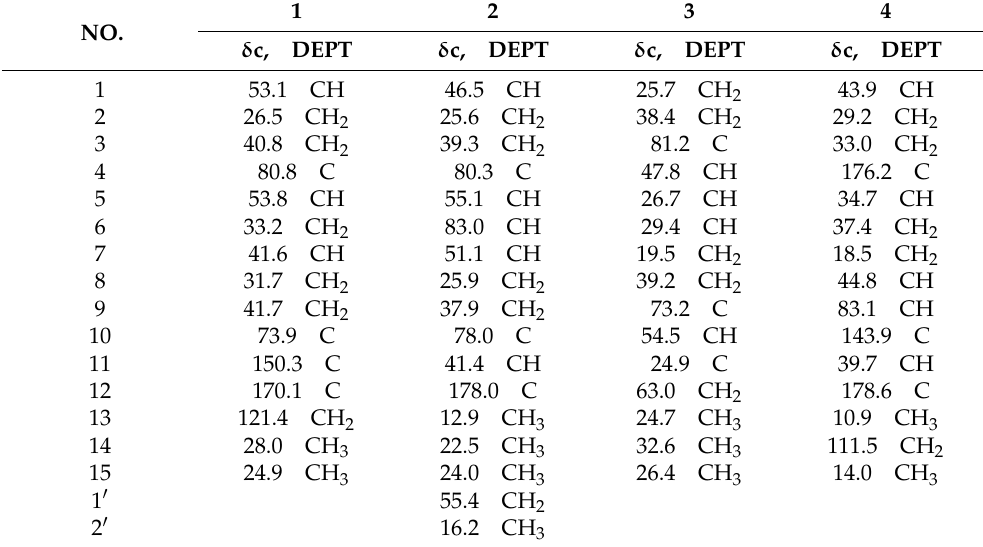
Table 2. 13 C NMR spectrum (150 MHz) data of compounds 1 – 4 .